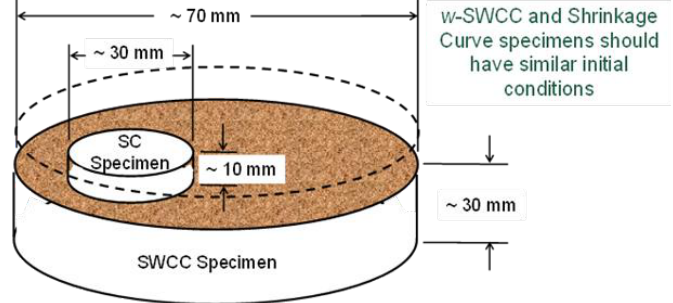
Figure 4. Relative sizes of the SWCC and SC specimens taken from the same soil sample.